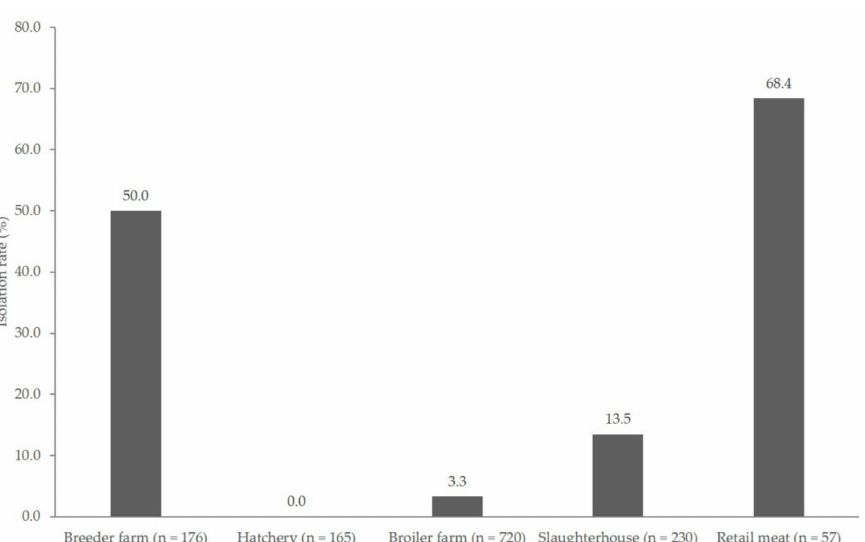
Figure 1. Prevalence of Campylobacter isolated from the chicken production chain. (n = total number of samples from each production